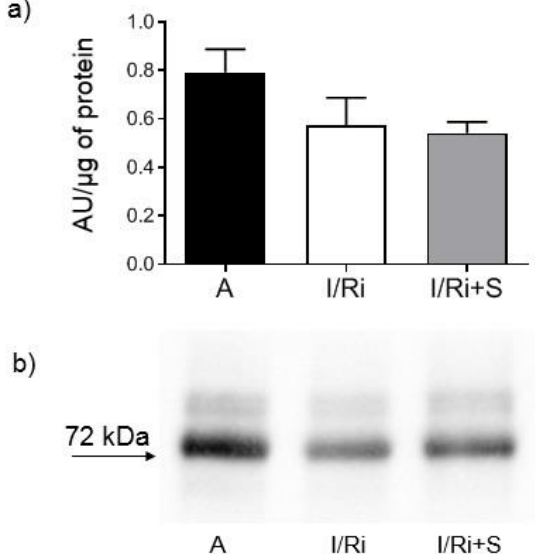
Figure 3. Effect of simvastatin on MMP-2 content in hearts subjected to ischemia-reperfusion ( a ) Analysis of MMP-2 content in heart tissue homogenates determined by Western blot showed no differences. MMP-2 expressed in arbitrary units per µg of protein. n = 5 – 6, ANOVA ( b ) Representative blot showing MMP-2 level in heart tissue homogenates. A — aerobic perfusion, I/Ri — ischemia-reperfusion injury, I/Ri + S — hearts from IR injury model treated with simvastatin. n = 5 – 6, ANOVA.